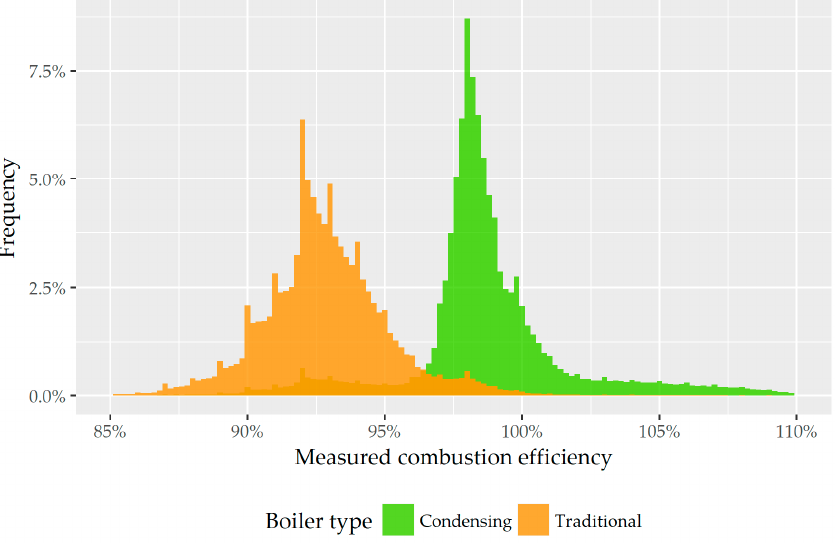
Figure 8. Distributions of nominal and measured (combustion) efficiency for Natural Gas boilers.